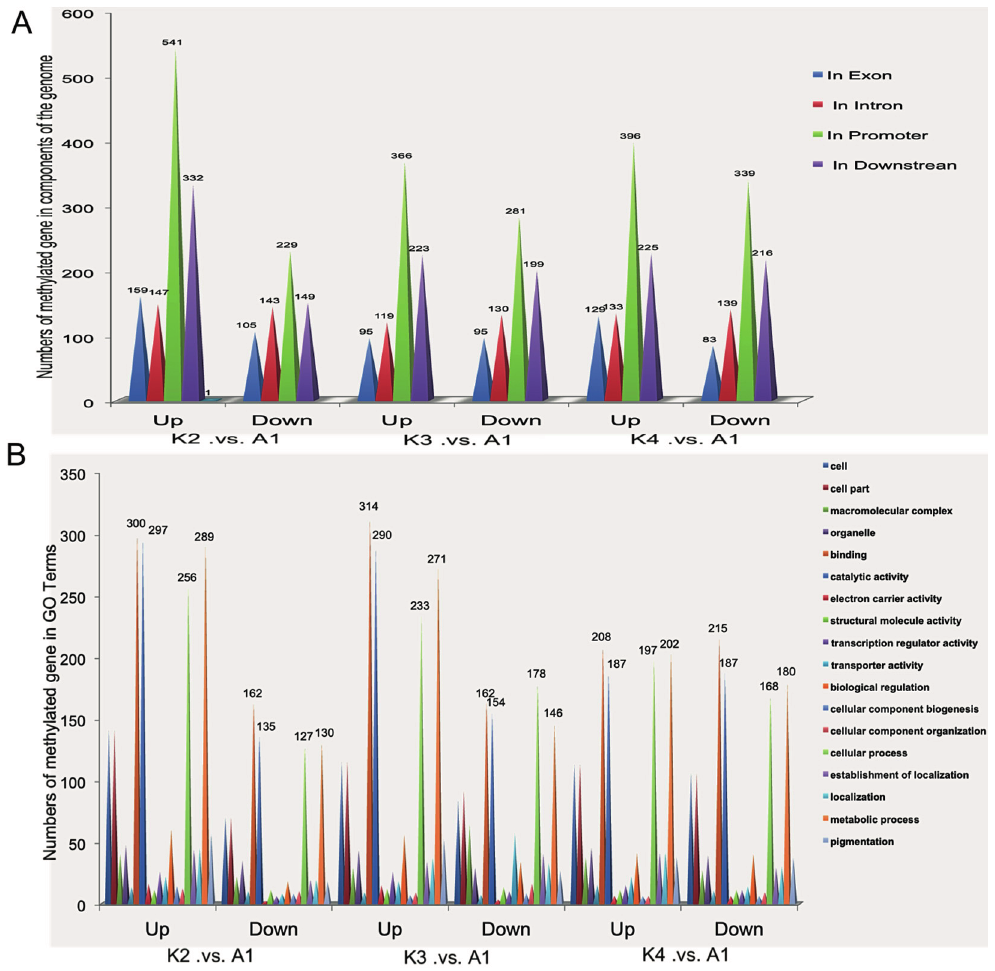
Figure 3. Identification and functional classification of the differentially methylated genes. ( A ) Identification of the differentially methylated genes in components of the genome in all three comparisons, including 1805 differentially methylated genes of K2 versus A1, 1508 of K3 versus A1, and 1660 of K4 versus A1; ( B ) Functional classification of the differentially methylated genes in three